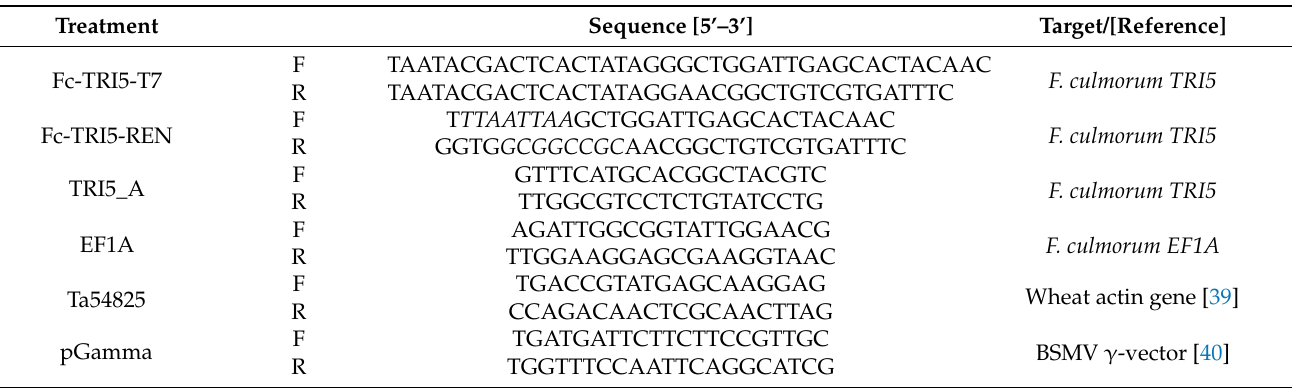
Table 1. List of primers used in this